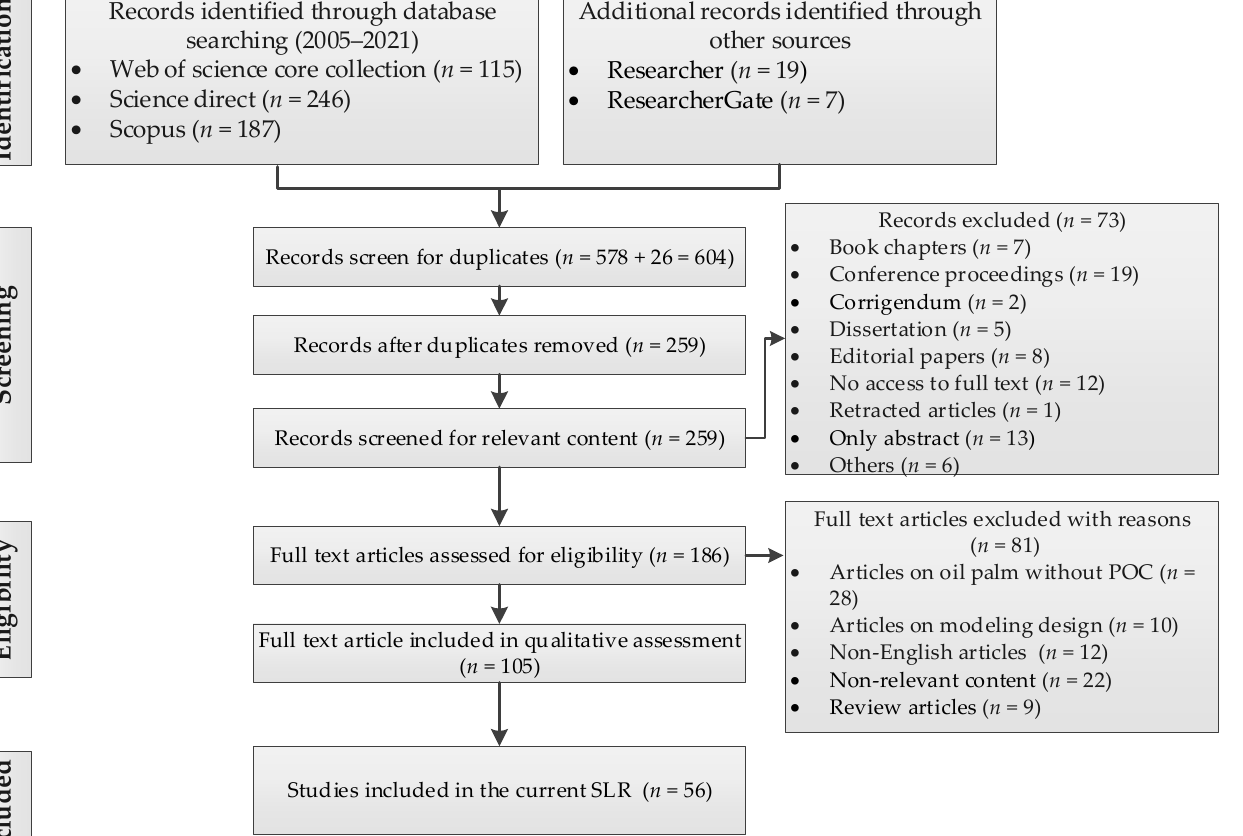
Figure 4. Flowchart for the PRISMA review process.